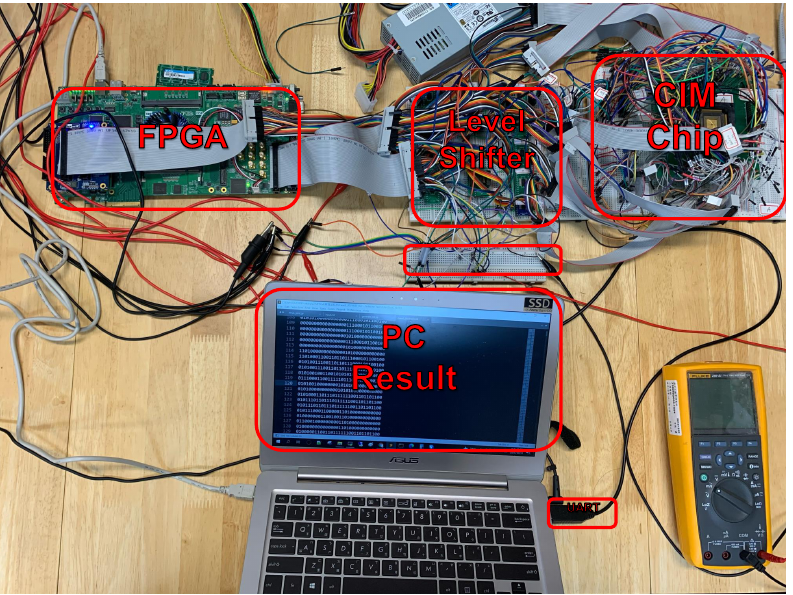
Figure 12. Experimental Setting for CIM SRAM and